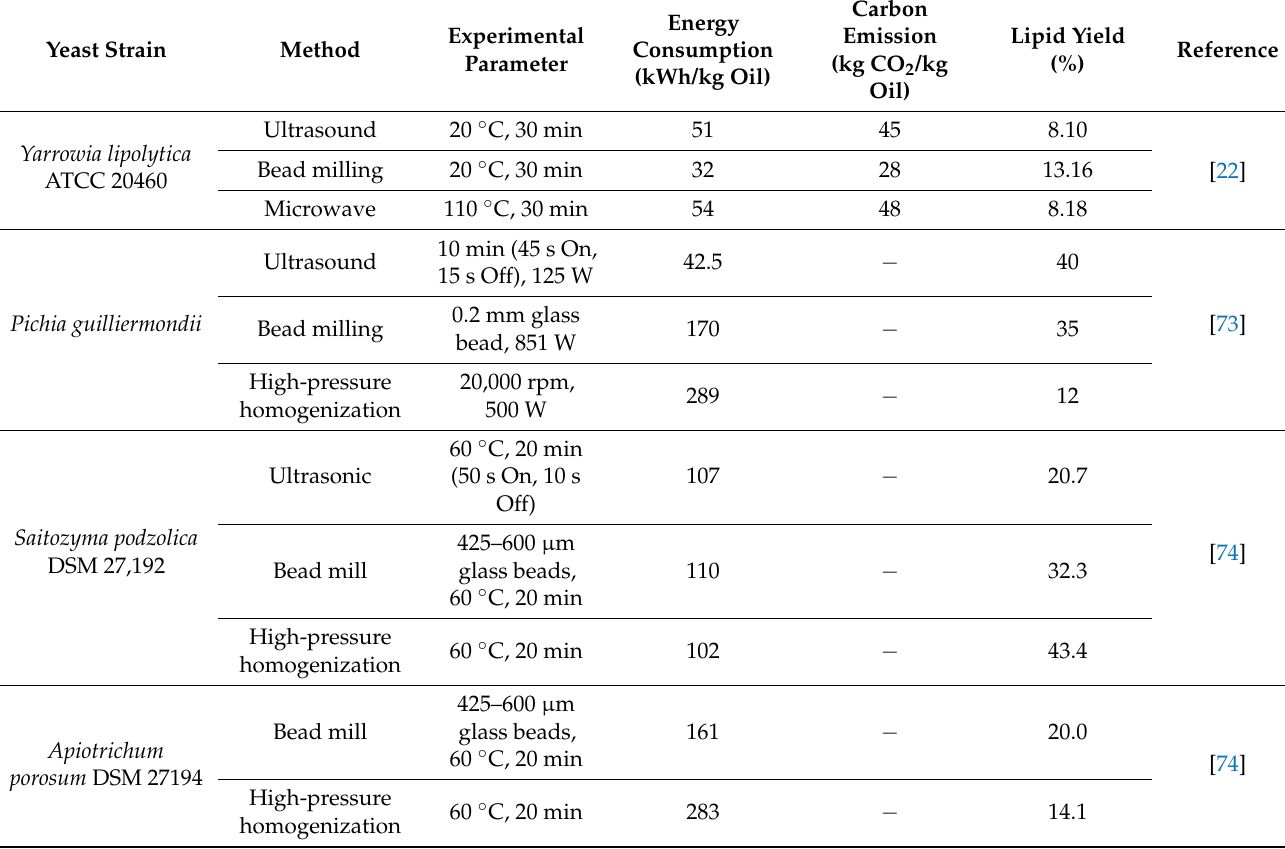
Table 2. Comparison of energy consumption by mechanical cell disruption methods for the extraction of lipids from oleaginous